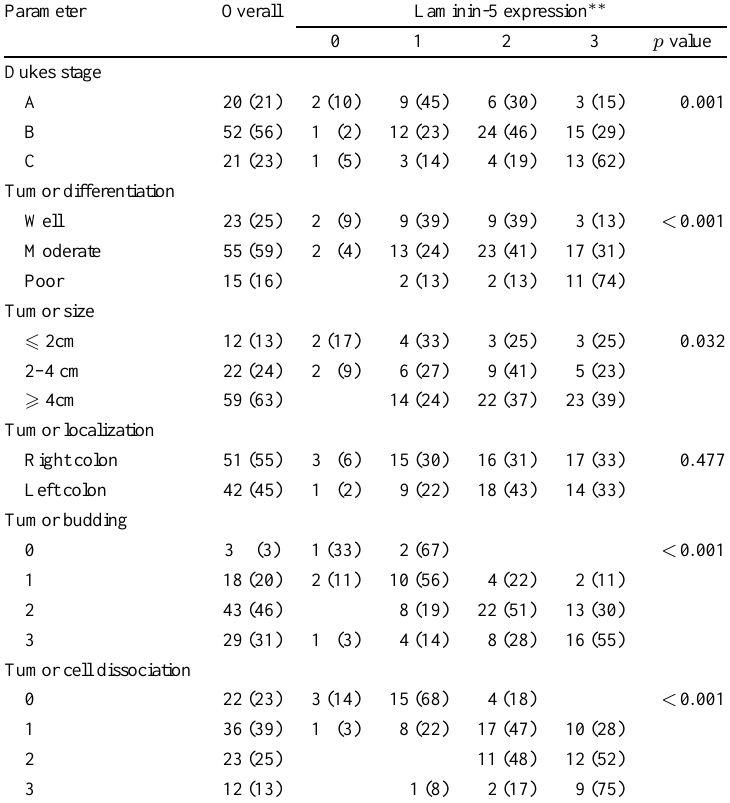
Correlations between clinicopathologic parameters and laminin-5 γ 2 chain expression in 93 colon carcinomas ∗ Parameter Overall Laminin-5 expression